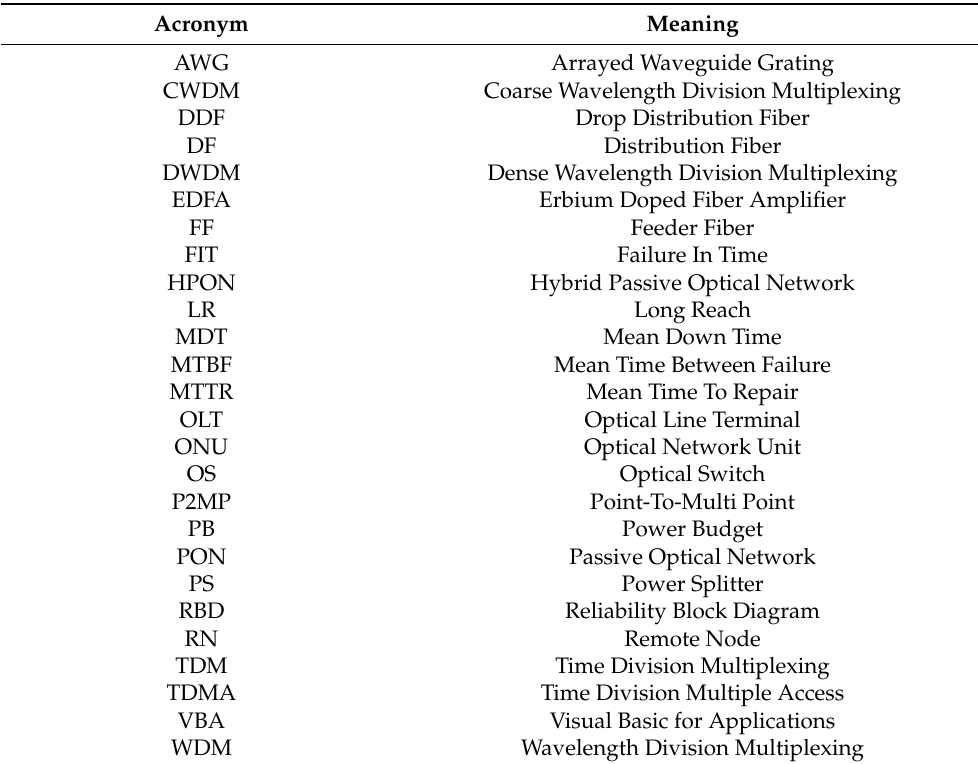
Table A1. Summary of frequently used acronyms and